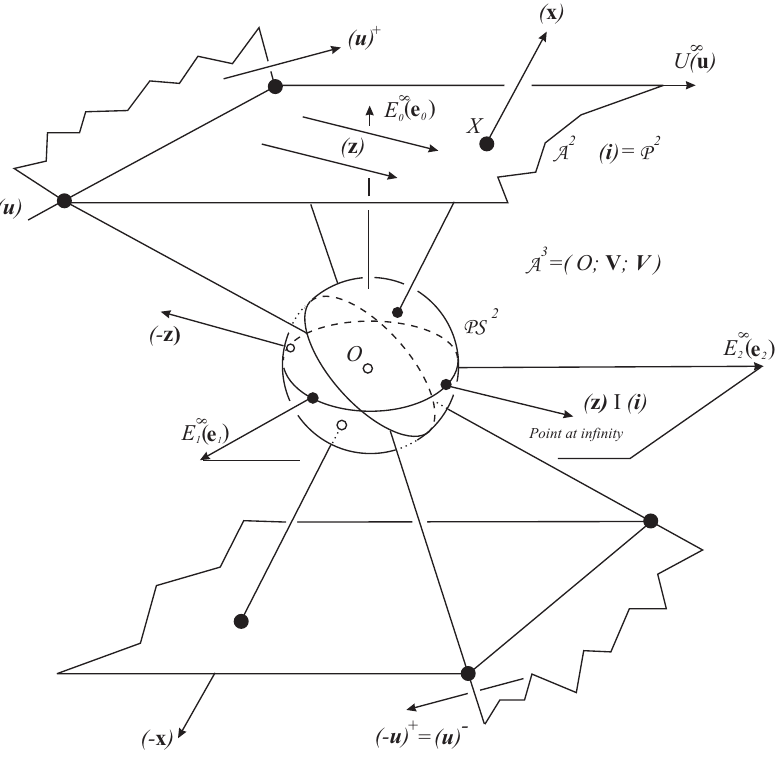
Figure 1. Our scene for dimensions 2 with projective sphere PS 2 embedded into the real vector space V 3 and its dual V 3 .